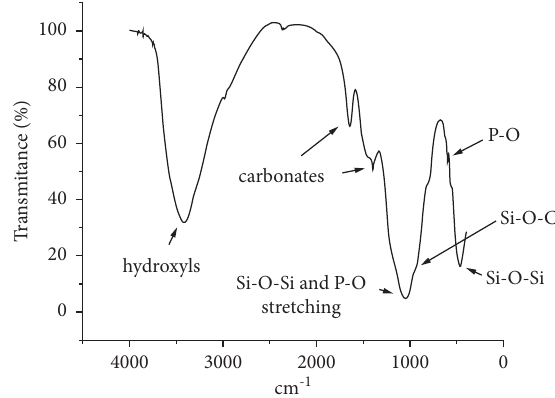
Figure 1: FTIR spectrum of synthesized